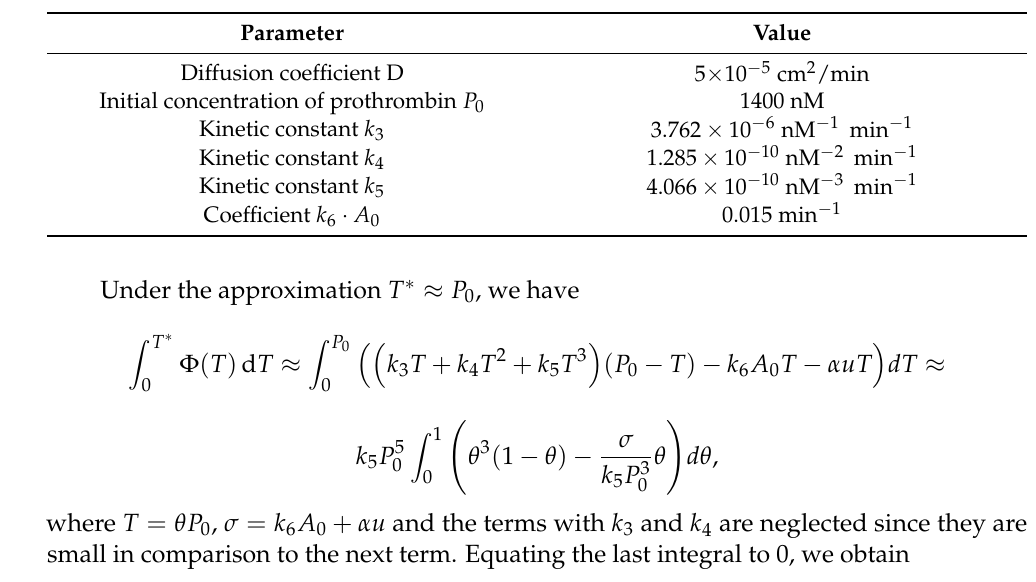
Table 1. Values of parameters in Equations (1)–(2) for the normal blood coagulation estimated from [17]. The speed of thrombin concentration wave propagation for these parameters is 0.54 mi- cron/s, which corresponds to the evaluative value for the normal blood coagulation [17]. The speed is calculated under the assumption of the absence of blood flow ( u =